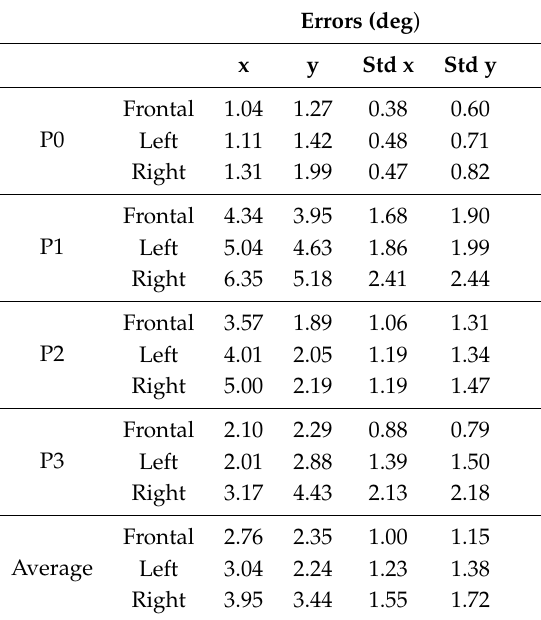
Table 2. Experienced gaze estimation errors under varying lighting conditions (light source described in the second column) with 4 typically-developed children. The headers of the columns Std x and Std y stand for standard deviation along x and y axes respectively. Errors (deg